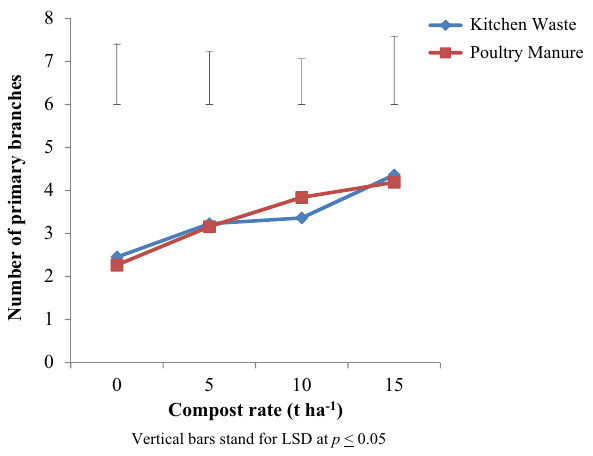
Fig. 2 Responses of primary branches of Corchorus to rates of com- post amendment. Vertical bars stand for LSD at p ≤